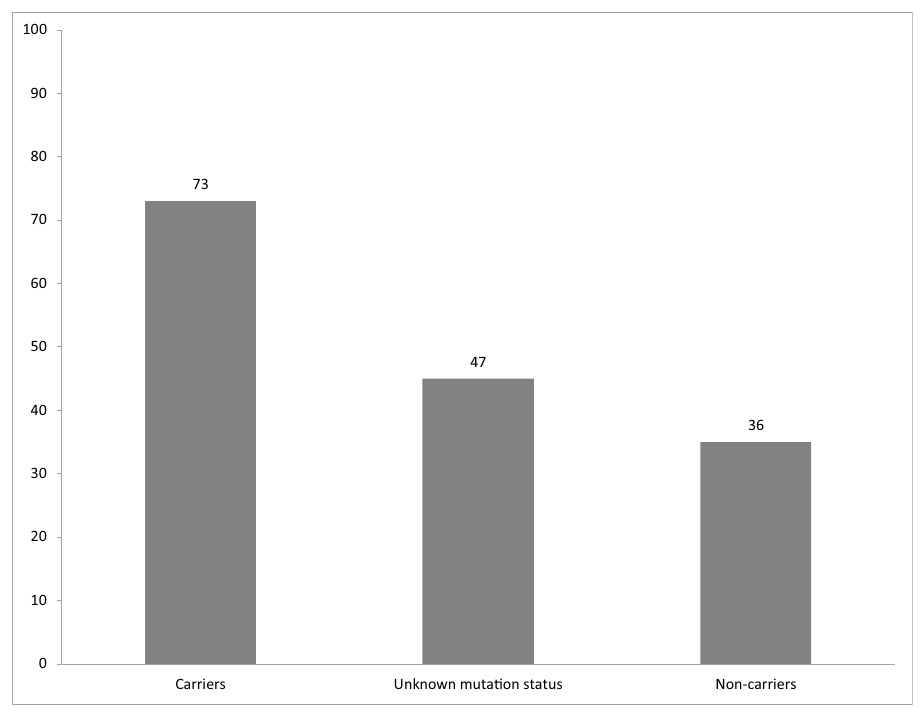
Figure 1. Colonoscopy use (percent) within past 2 years stratified by variant